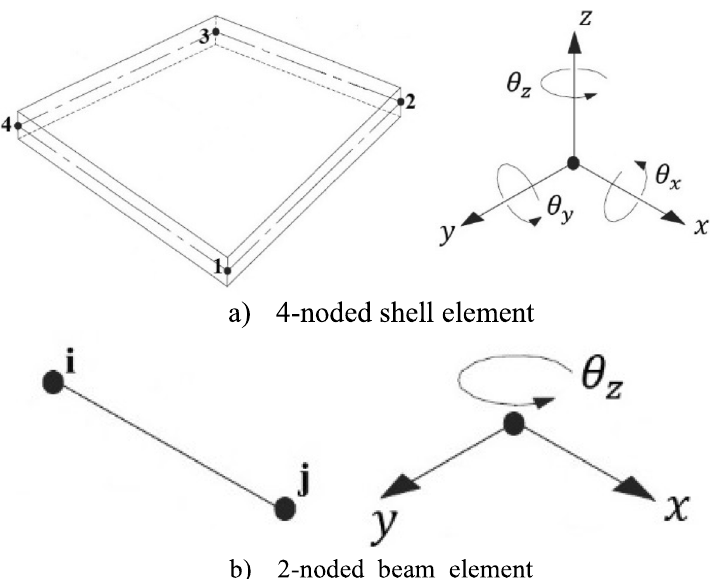
Fig. 7 Description of elements. a 4-noded shell element. b 2-noded beam